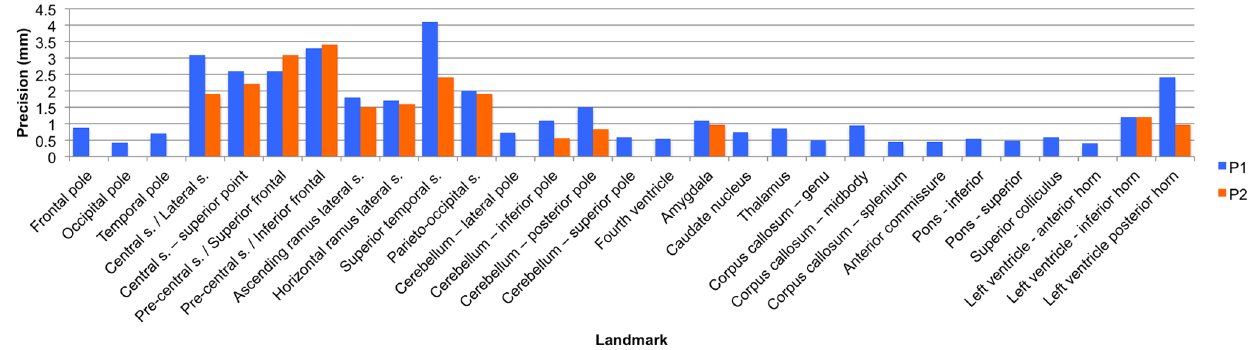
Figure 3. Histogram of the inter-observer precision of each landmark. This histogram indicates the level of inter-observer precision associated with each landmark using the original (P1) and modified (P2) protocols. Landmark numbers correspond with the landmark numbers in Table 2.